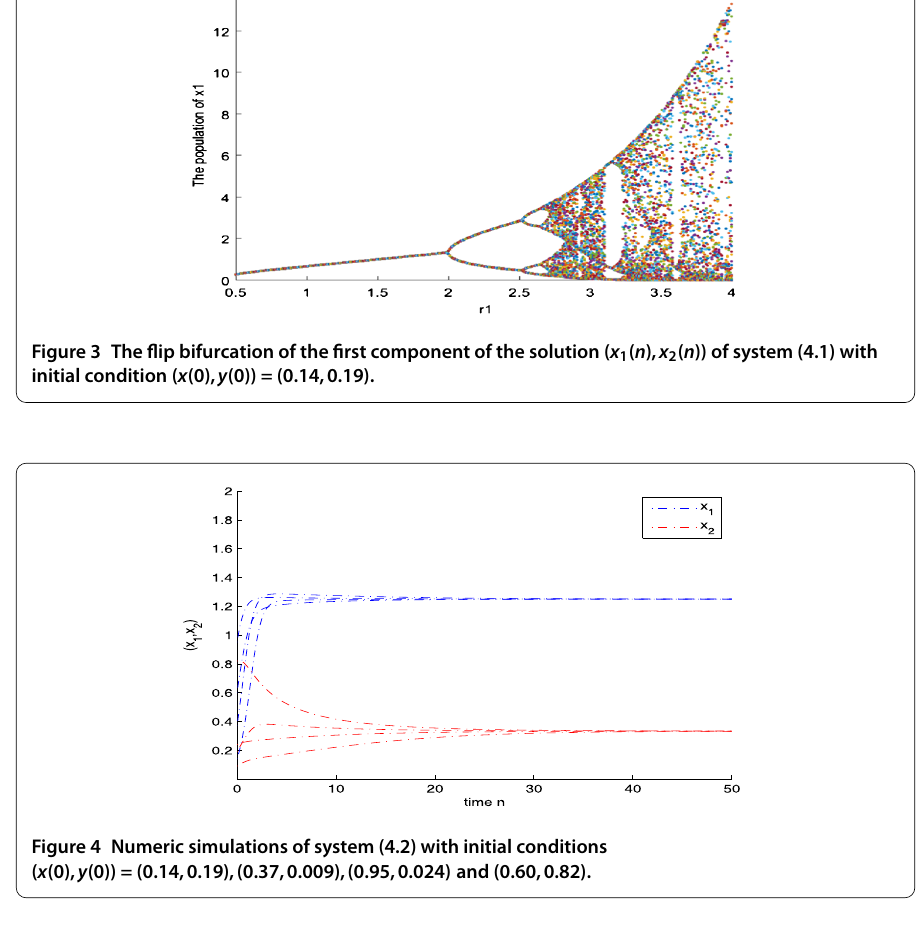
species x  with initial condition ( x (), y ()) = (.,.) and r  = . : . : . The